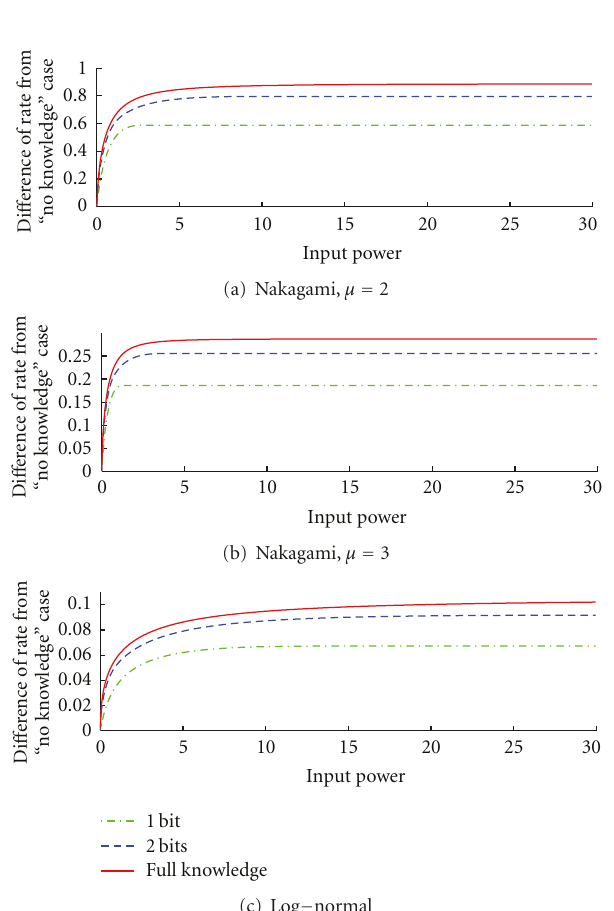
Algorithm 1: Capacity lower bound optimization.